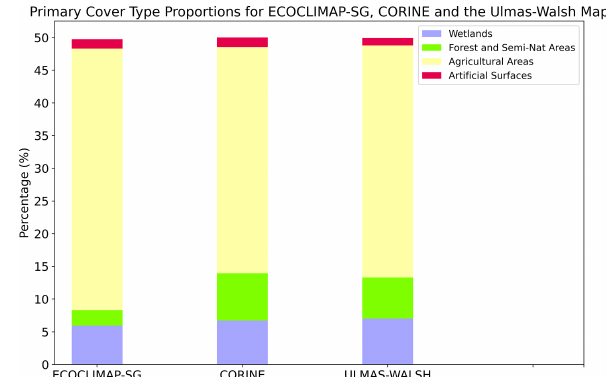
Figure 6. Jaccard Index (Intersection Over Union) for the 5 land- cover labels when comparing ECO-SG (blue) and the Ulmas-Walsh map (orange) with